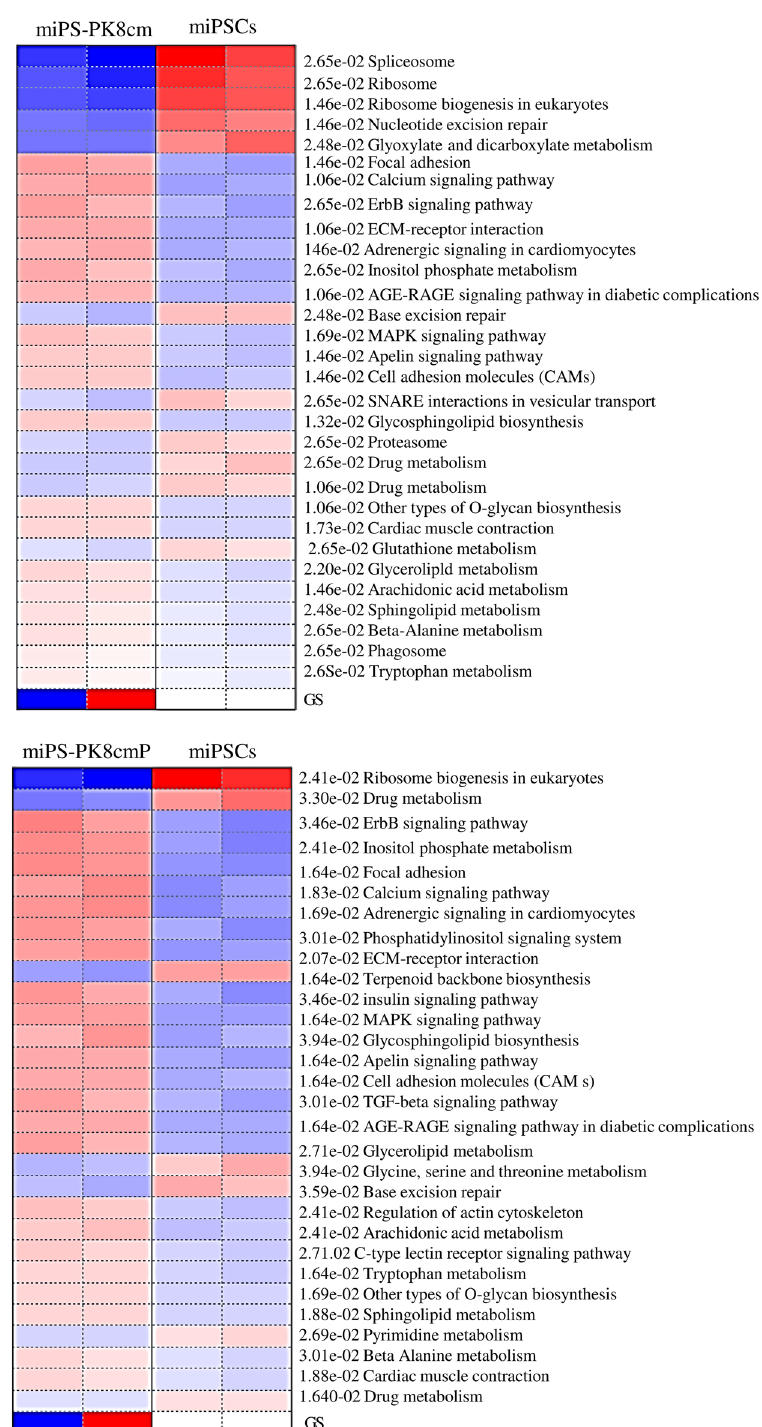
Figure 2. The top enriched pathways in CSCs converted from miPSCs. The top enriched pathways for the upregulated genes in miPS-PK8cm and miPS-PK8cmP cells compared with miPSCs. Red and blue indicates activated and suppressed pathways,